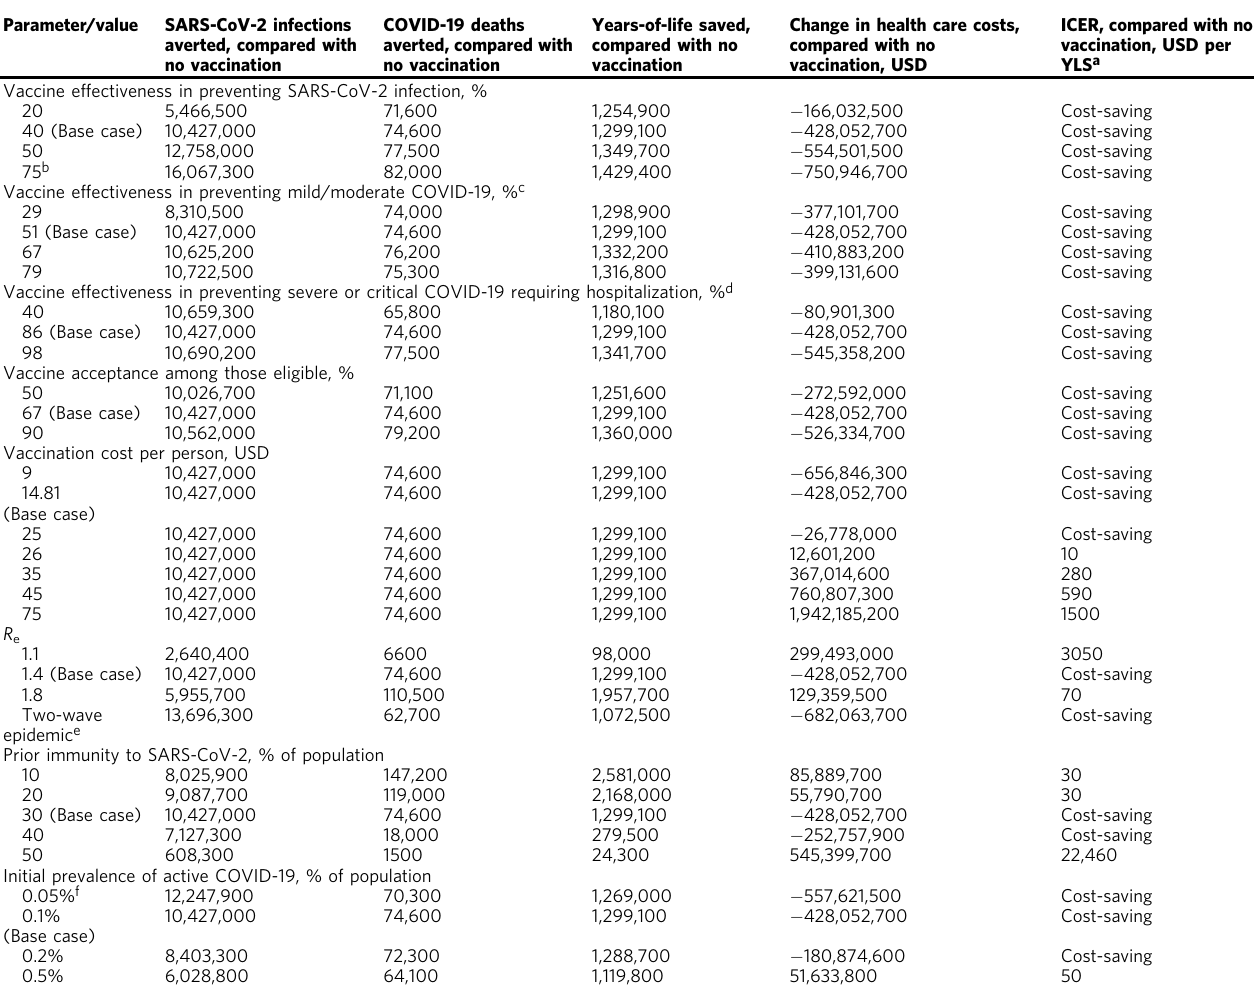
ICER, compared with no vaccination, USD per YLS a